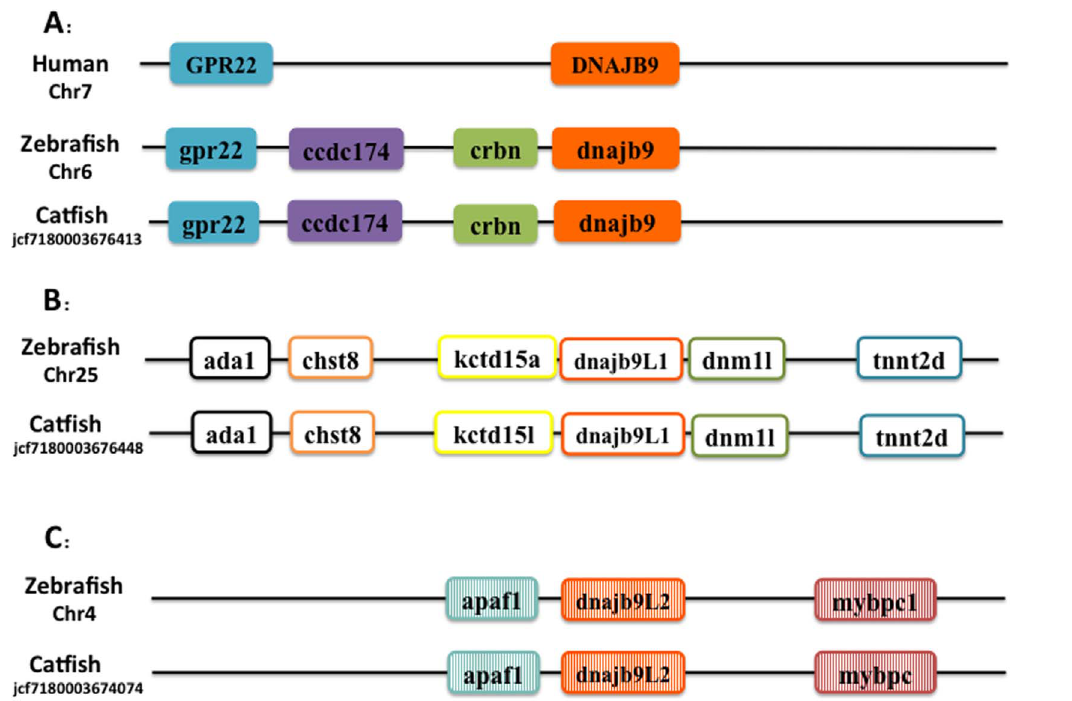
Fig. 2. Schematic presentation of the conserved synteny blocks neighboring Dnajb9 gene (A) Dnajb9-like1 gene (B) and Dnajb9-like2 gene (C). Note that in each case, the gene order and orientation was relatively conserved. Abbreviations: (A) GPR22, G Protein Receptor 22; Dnajb9, Dnaj (Hsp40) homolog, subfamily B, member 9; ccdc174, Coiled-Coil Domain Containing 174; crbn, cereblon. (B) ada1, Adenosine Deaminase; chst8, carbohydrate (N- acetylgalactosamine 4–0) sulfotransferase 8; kctd15a, potassium channel tetramerisation domain containing 15a; dnajb9L1 DnaJ (Hsp40) homolog, subfamily B, member 9 like 1; dnm1l, dynamin 1-like; tnnt2d, troponin T2d, cardiac. (C) apaf1, apoptotic protease activating factor 1; dnajb9l2 DnaJ (Hsp40) homolog, subfamily B, member 9 like 2; mybpc, myosin binding protein